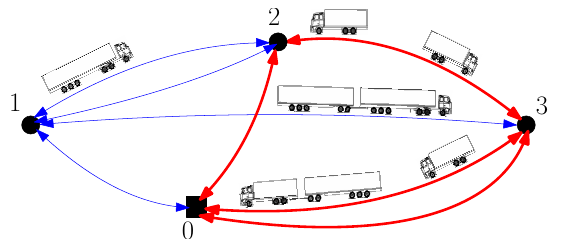
Figure 1. Schematic of transportation network and vehicle fleet. Mission comprising nodes 0, 2, and 3 is depicted with different routes connecting the nodes marked in bold red